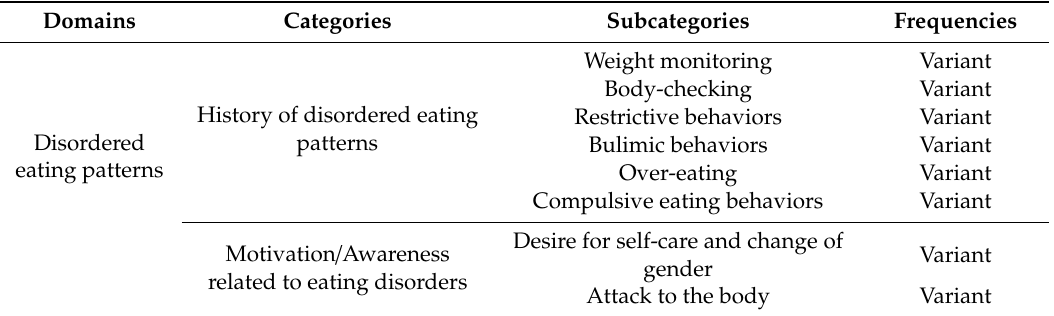
Table 3. Domains, categories and subcategories of the area of Eating